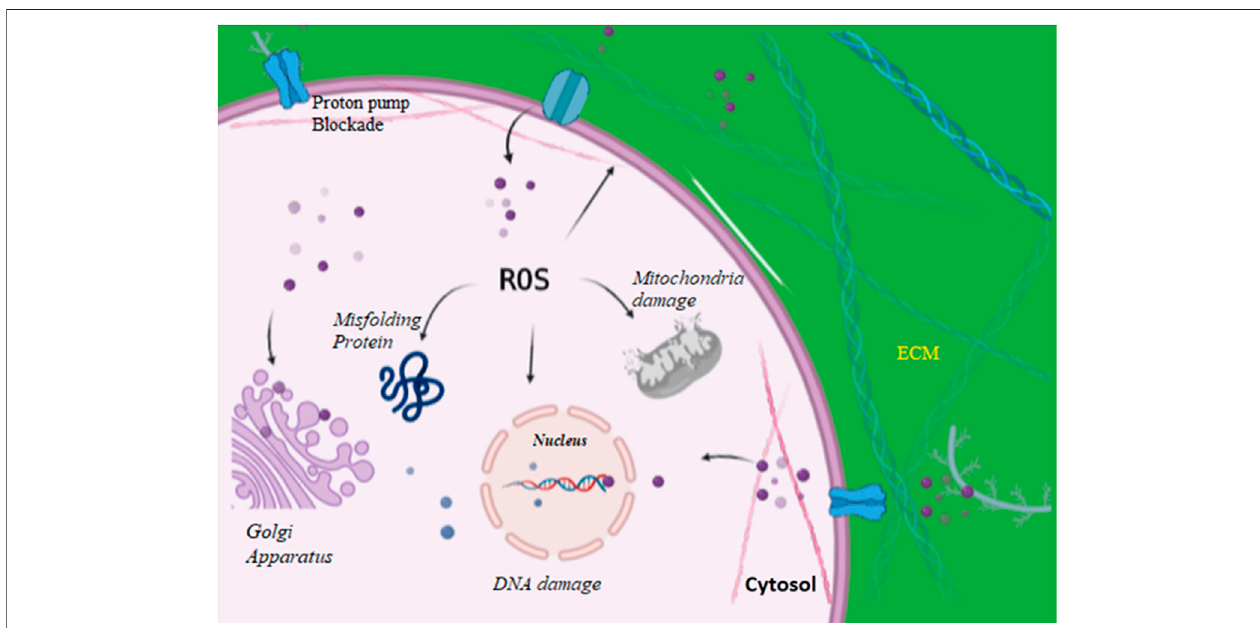
FIGURE3| AgNPsenter intothe cell via protonpumps and increasing reactive oxygenspecies therebydamaging intracellular organelles, blocking proton pumps, and causing damage to cell wall.